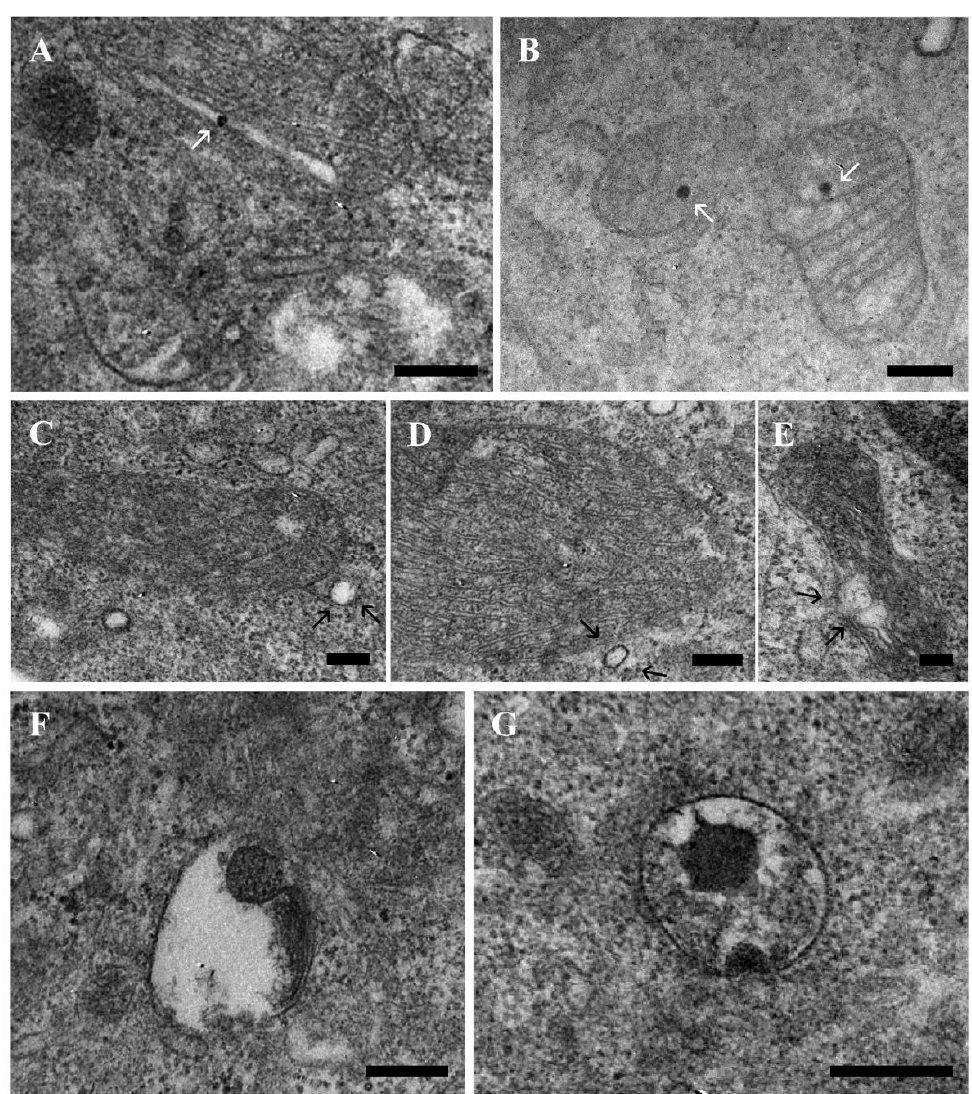
Figure 4. Ultrastructure of U937 cells incubated with SiNP. Electron-dense particles internalization in the mitochondria is present in ( A , B ). Small MDVs formation from mitochondria membranes is visible in ( C – E ). Transient ( F ) and complete ( G ) formation of endolysosomes is observable. A , D , E , bar = 100 nm: B , C , E , F , bar = 200 nm; G , bar = 250 nm.